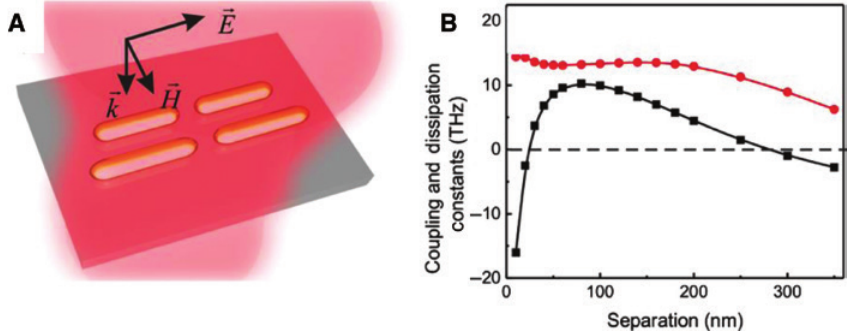
Figure 1: Optical coupling between two optical antennas, which include real (Hermitian) and imaginary (anti-Hermitian) couplings. (A) Plasmonic system consisting of two optical antennas made of gold. The system is deep subwavelength. (B) Simulated real part (black square) and imaginary part (red circle) of optical coupling constant between the two antennas, as a function of their separation s . The coupling consists both the direct near-field coupling and indirect coupling through the radiation channel. At a very small separation, the coupling has a huge negative real part that comes from the direct near-field coupling. When the spacing increases, the magnitude of the near-field coupling decreases rapidly. When s reaches 30 nm, the direct near-field coupling cancels with the real part from indirect far-field coupling, leaving a pure imaginary (anti-Hermitian) coupling. Reprinted from Ref. [25]. Copyright © 2012 by the American Physical Society.